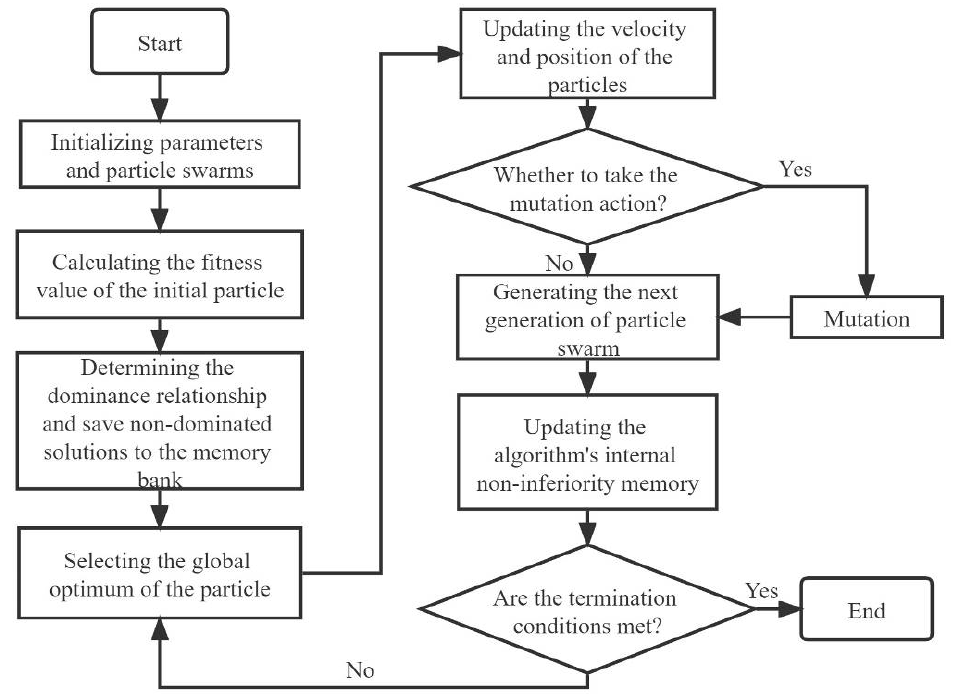
Figure 3. Flowchart of M-MOPSO algorithm.